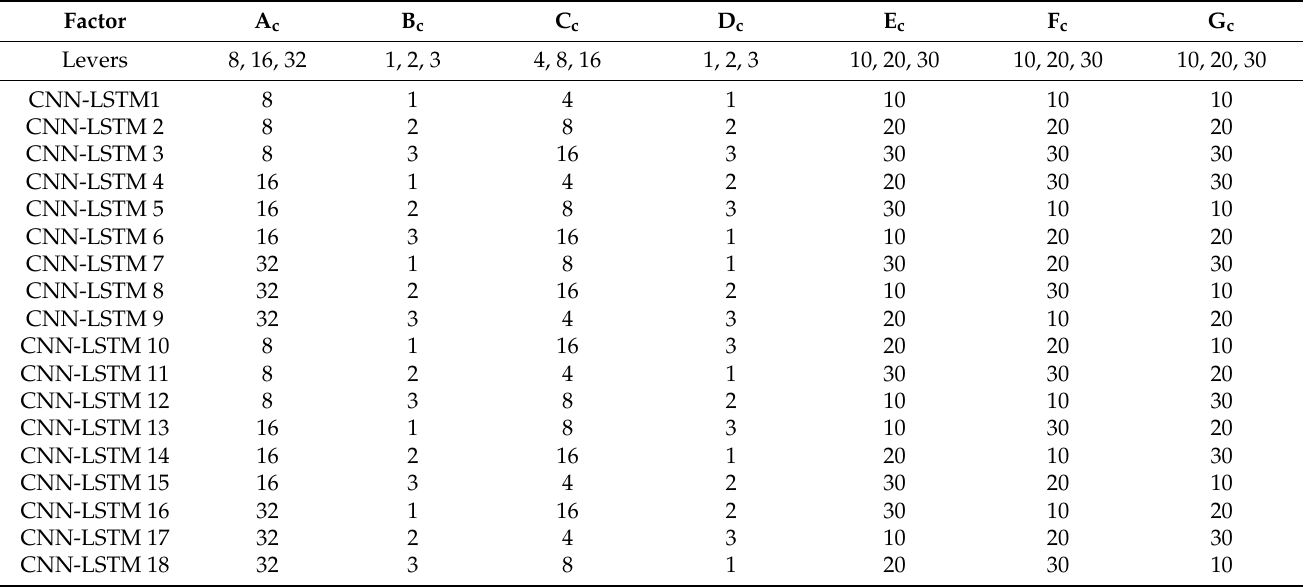
Table 5. The results of an orthogonal design experiment for the hyperparameter of CNN-LSTM